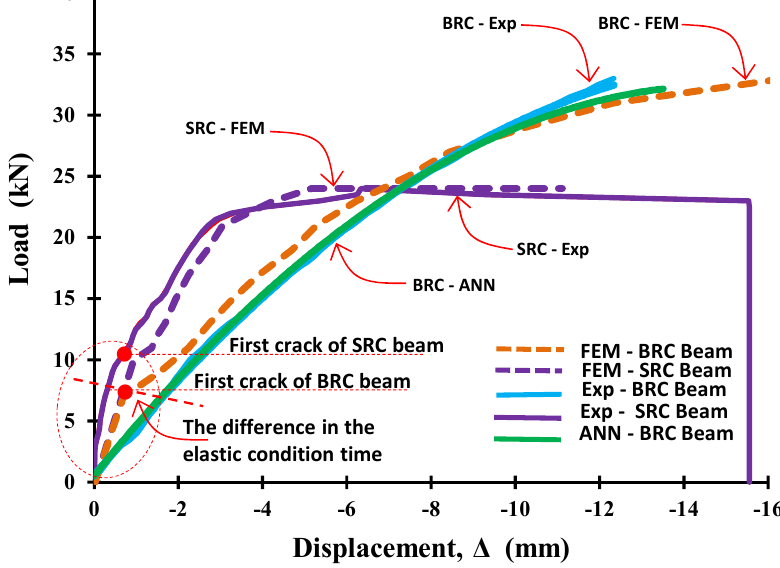
Figure 20. The combined of the load vs. displacement relationship of BRC beam and SRC beam of the experimental results, ANN analysis, and FEM.